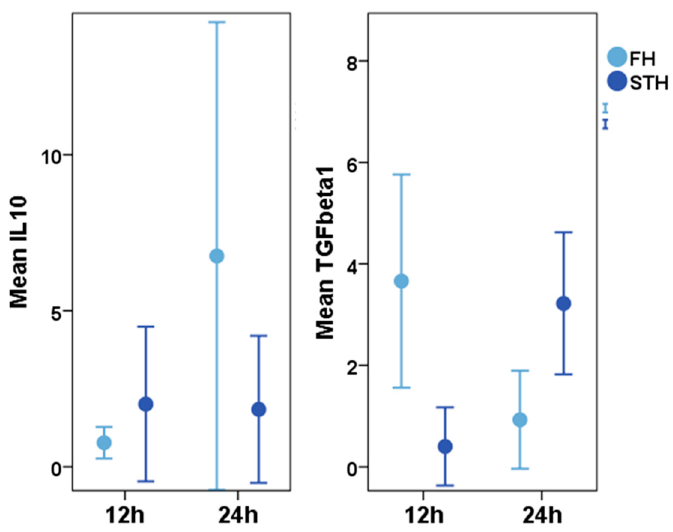
Figure 5. Expression values for IL-10 (interleukin 10) and TGF- β 1 (transforming growth factor beta 1) (median values) in a haematoma in the diaphyseal part of sheep tibia (bone haematoma = light blue) and in the gracilis muscle (without any contact to bone/muscle haematoma = dark blue) during the first 24 h after injury. Cytokine expression was measured 12 and 24 h after injury. n = 6. Using Mann Whitney U for paired and Wilcoxon for unpaired samples, a descriptive statistical analyses revealed an increase of IL10 in the FH p = 0.041 and a decrease of TGF β 1 p = 0.015; within the STH, no increase of Il10 was monitored while TGF β 1 increased p = 0.009, different expression pattern within the FH and STH lead to a difference in TGF β 1 expression at 24 h after injury p = 0.031. For more details, please refer to [16].